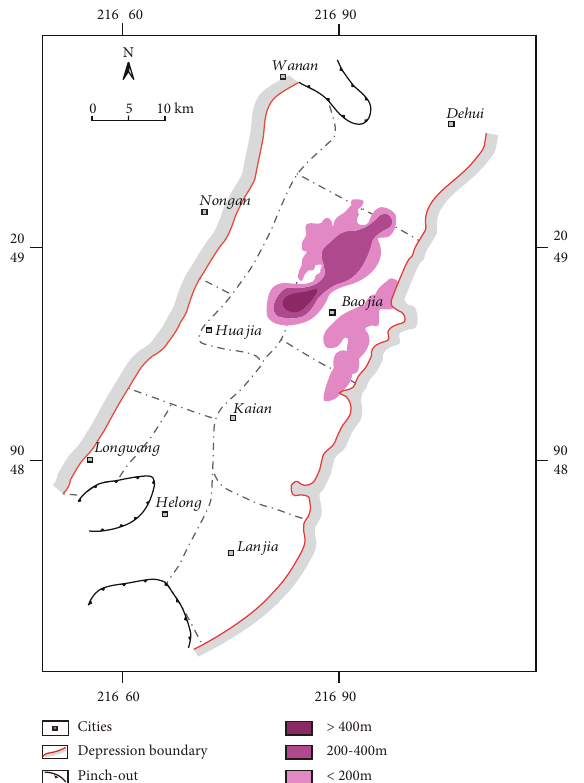
Figure 8: Distribution of volcanic rock reservoir of the K